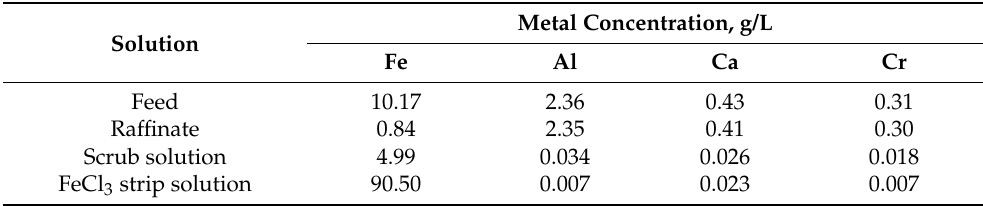
Table 3. Composition of the feed solution, raffinate, scrubbing solution, and FeCl 3 solution.